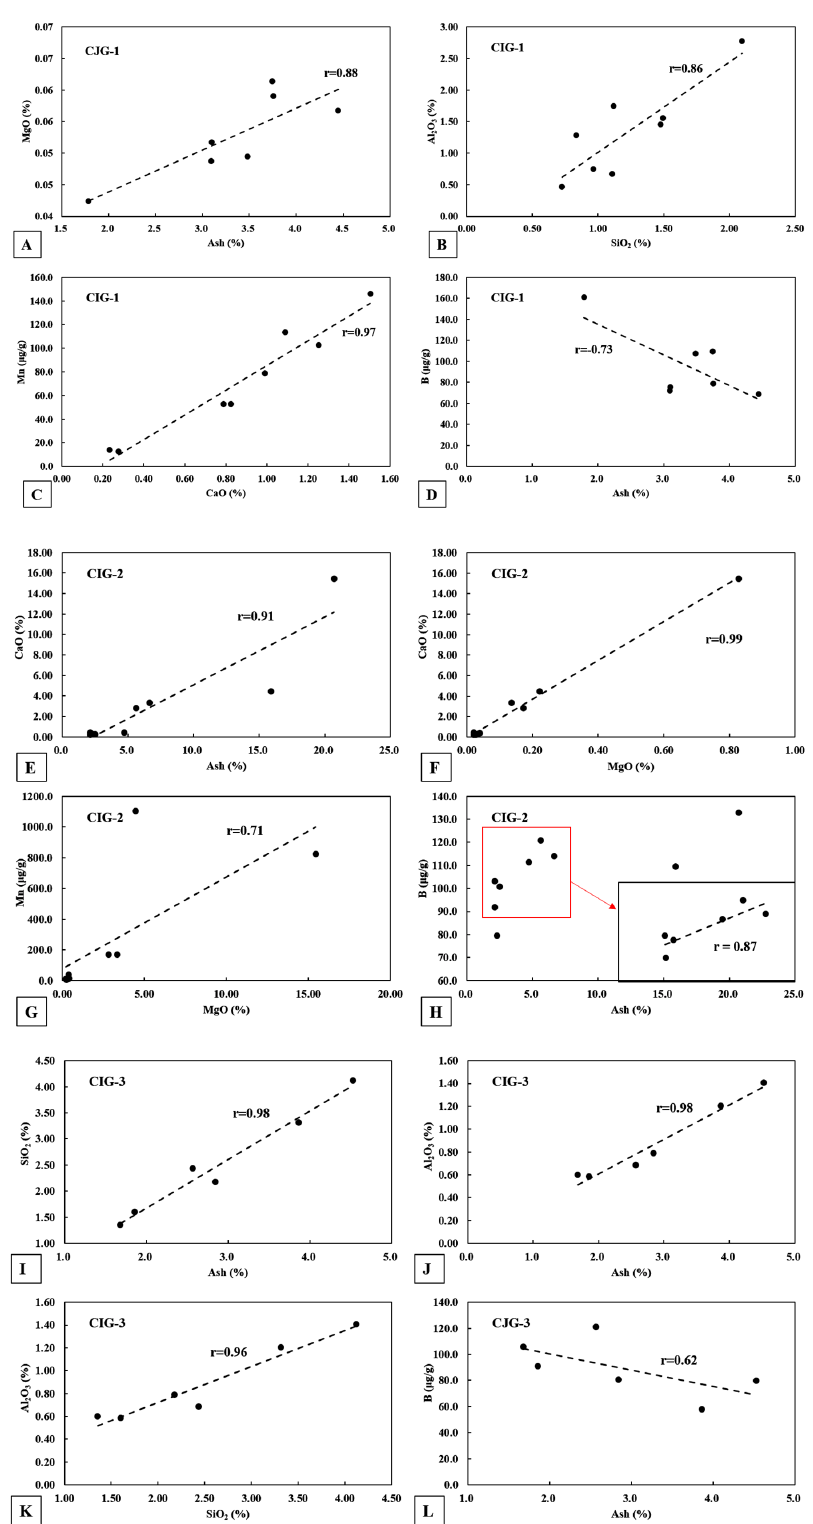
Figure 13. Relationship between selected elements / oxide and ash yield in Jurassic coals (CJG-1, 2, 3). CJG-1: ( A ) MgO-Ash yield; ( B ) Al 2 O 3 -SiO 2 ; ( C ) Mn-CaO; ( D )B-Ash yield. CJG-2: ( E ) CaO-Ash yield; ( F ) CaO- MgO; ( G ) Mn-MgO; ( H )B-Ash yield. CJG-3: ( I ) SiO 2 -Ash yield; ( J ) Al 2 O 3 -Ash yield; ( K ) Al 2 O 3 - SiO 2 ; ( L )B-Ash yield.